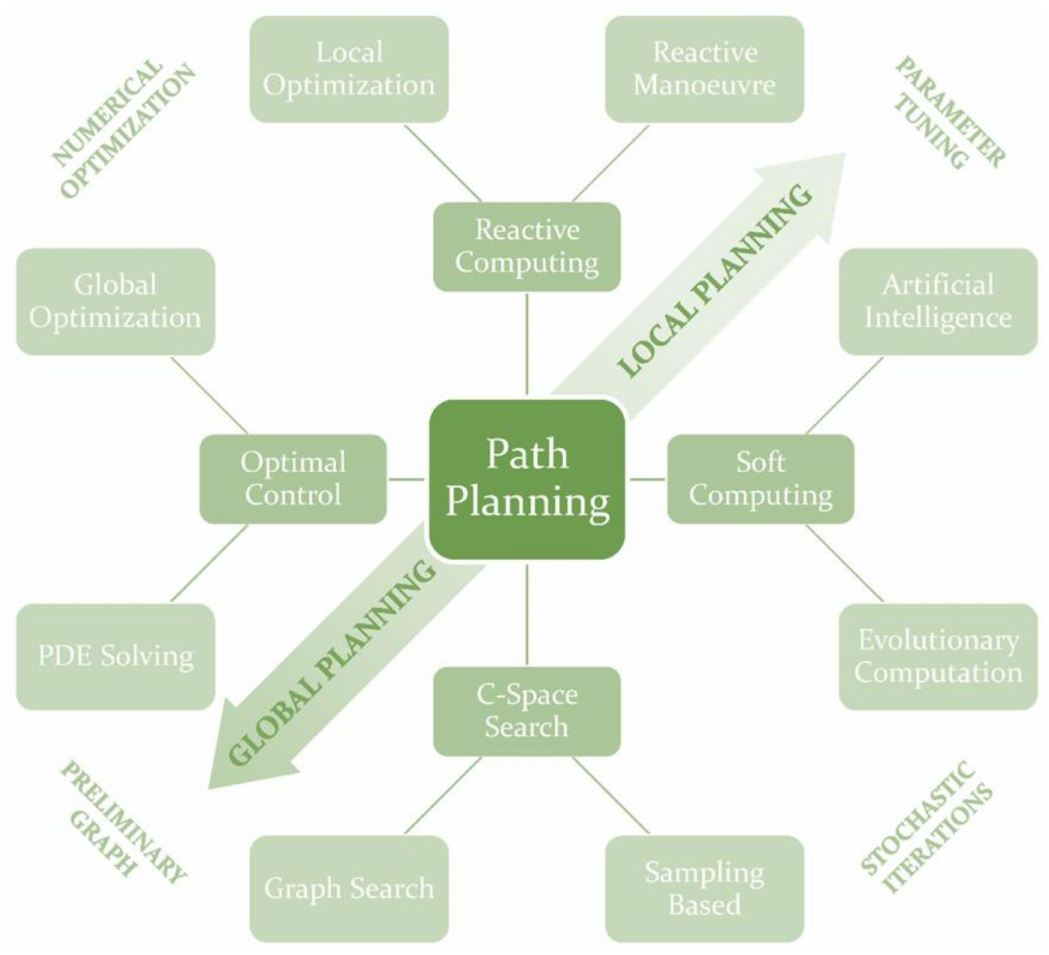
Figure 3. Division of methods path